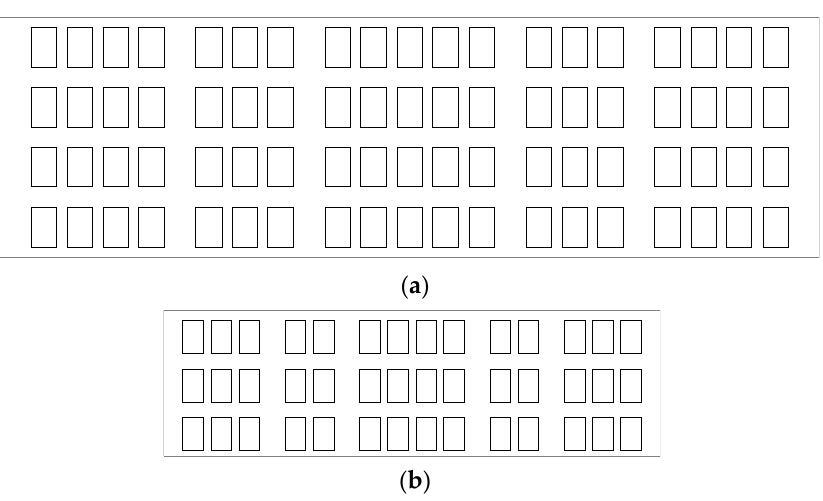
Figure 10. Typifying a façade whose windows are not evenly distributed in both directions: ( a ) original façade which can be composed of several segments; ( b ) Typified for scale reduced by 2×.